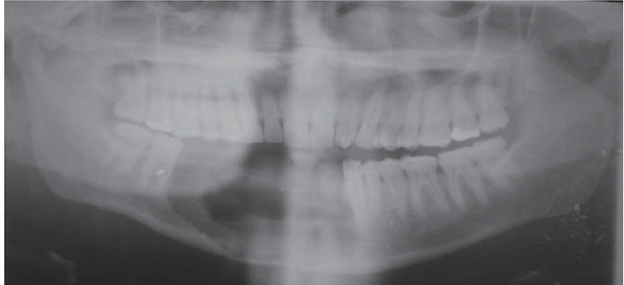
Fig. 10. Postoperative orthopantomogram showing the wide excision of the